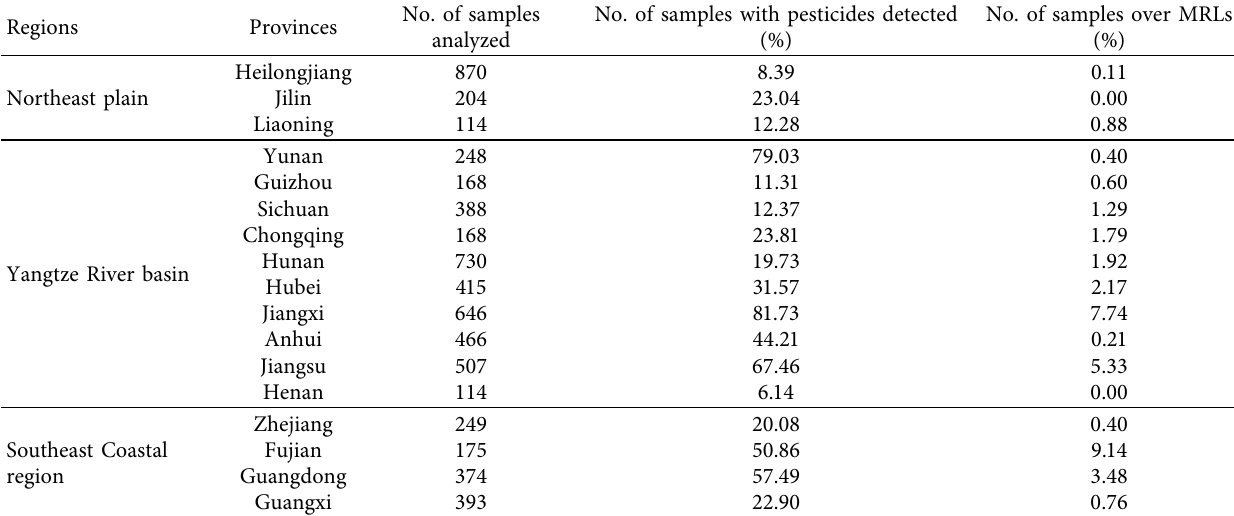
Table 3: The regional distribution of pesticide residue levels in brown rice samples in different provinces in China.